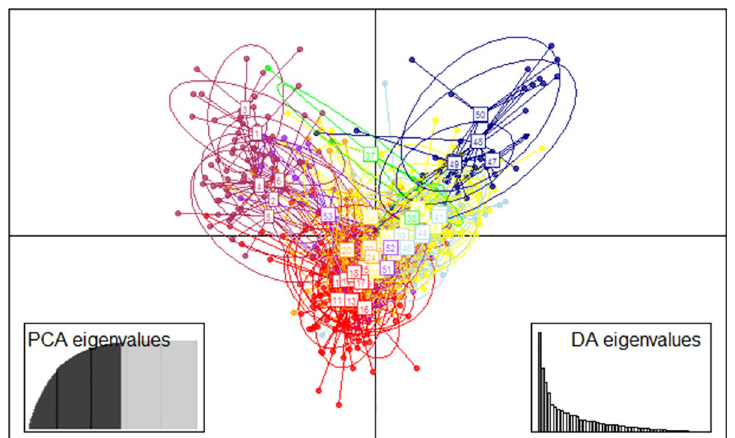
Fig 4. Discriminant analysis of principal components for the Ae . albopictus populations in Japan. 1–6: Fukuoka A colored by maroon; 7–18: Fukuoka B colored by red; 19–25: KK1-KK7 colored by orange; 26–36: NG1-NG11 colored by yellow; 37–38: GT1-GT2 colored by green; 39–46: TS1-TS8 colored by light blue; 47–50: RK1-RK4 colored by navy blue; and 51–53: HS1-HS3 colored by purple.